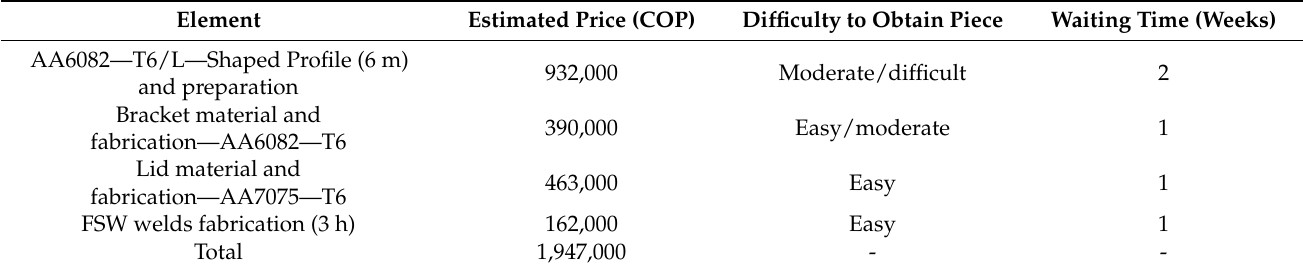
Table 3. Cost estimate of materials and resources required in Colombia to replicate